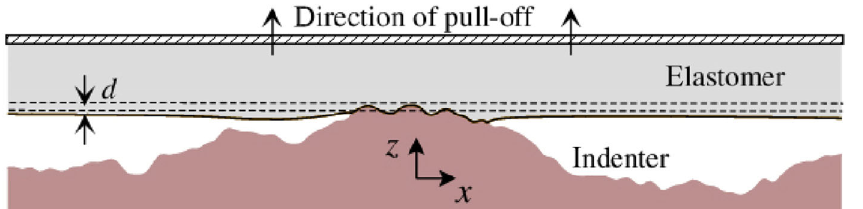
Fig. 1 Cross-section of an adhesive elastic body, which is pulled off a rigid, self-affine substrate. The interference d is the difference between the elastic body's bottom-surface center-of-mass and the indenter's highest point. The shown cross-section contains the highest point of our default configuration. The shown cross-section is 10% of a cut through the square simulation